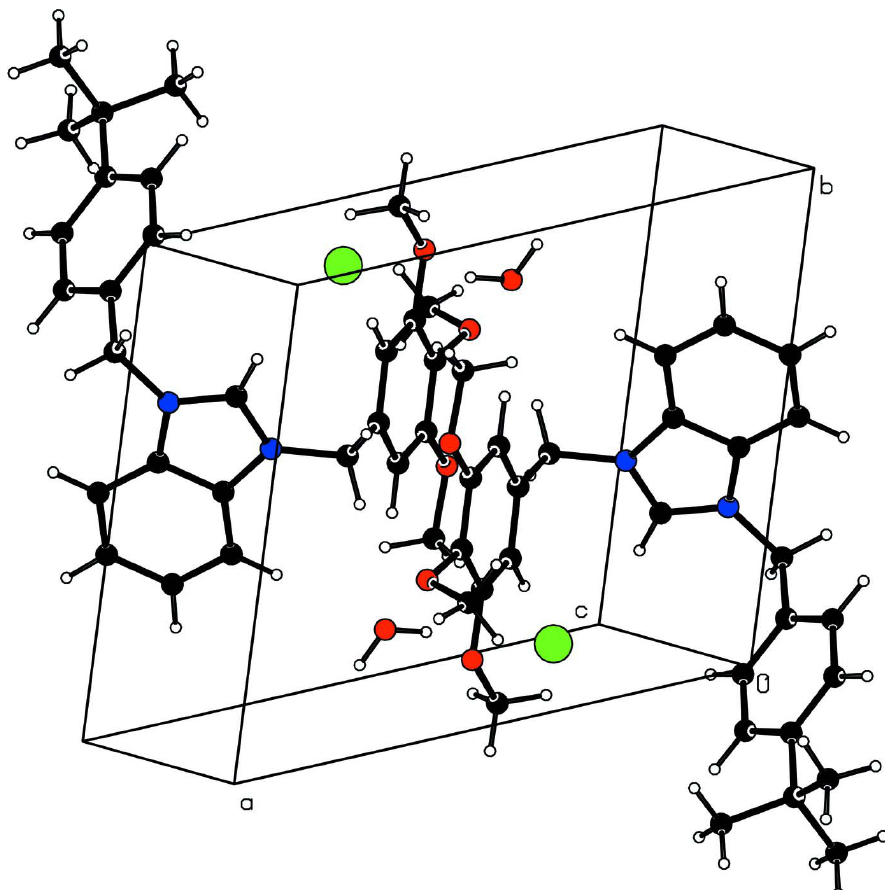
Figure 3 A packing diagram for